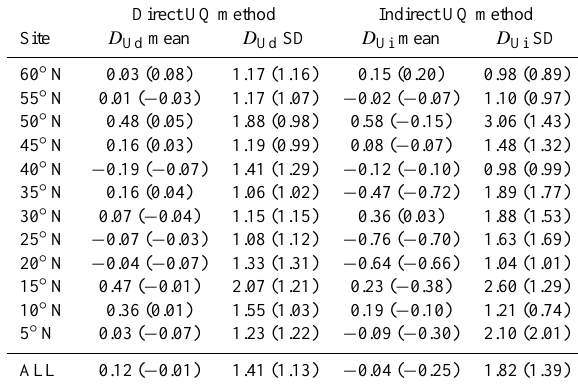
Table 3. Uninformed emulator robustness evaluation for all 10 ex- periments and for the 9 experiments excluding Experiment